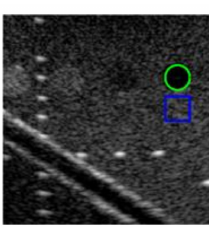
Figure 4. The test image with ROIs of target cyst (green) and background (blue) for quantitative analysis.